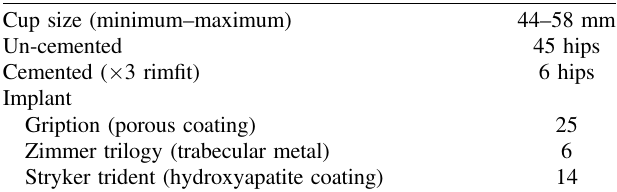
Table 2. Use of cemented and uncemented cup with